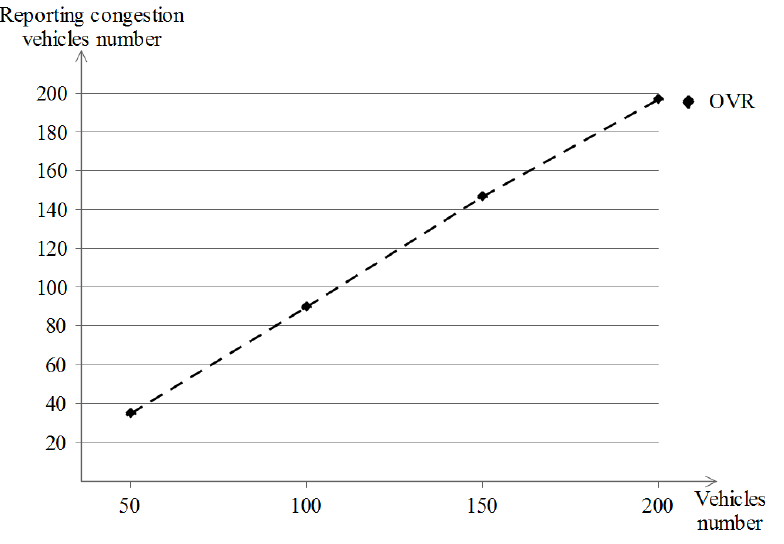
Figure 23. Number of vehicles that reported road congestion at least once in the Manhattan